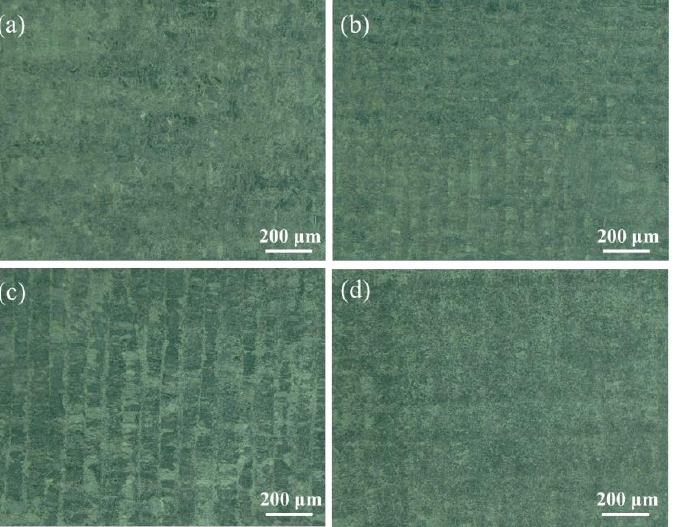
Figure 3. Morphologies of grains under optical microscopy from top view (in XOY section): ( a ) 200 W power and 600 mm/s scanning velocity; ( b ) 200 W power and 800 mm/s scanning velocity; ( c ) 320 W power and 600 mm/s scanning velocity; ( d ) 320 W power and 800 mm/s scanning velocity.